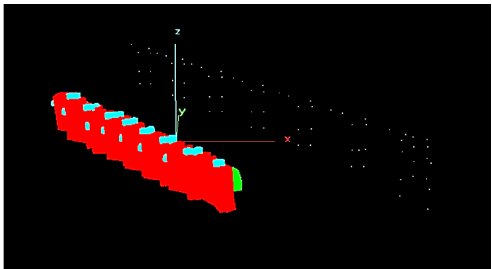
Figure 12. Camera configuration resulted from resection process